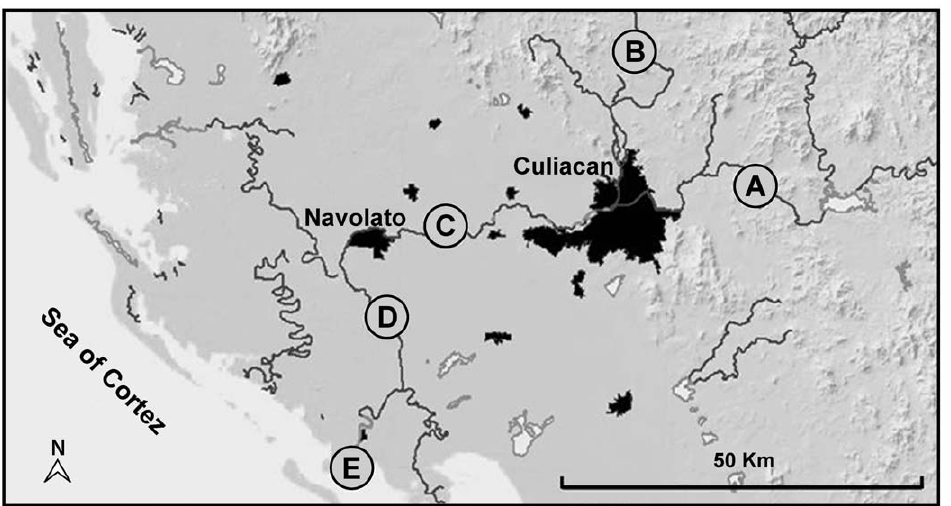
Figure 1. Sampling sites in the Culiacan Valley in Northwest Mexico. Map of the five sampling sites, Jotagua (A), Agua Caliente (B), Cofradia de Navolato (C), Iraguato (D), and El Castillo (E) that were selected to be 14–38 km apart and to represent the study area in the Culiacan Valley, Sinaloa, Mexico. Dark areas in the map indicate urban zones with more than 20,000 inhabitants. Scale bar corresponds to 50 km.